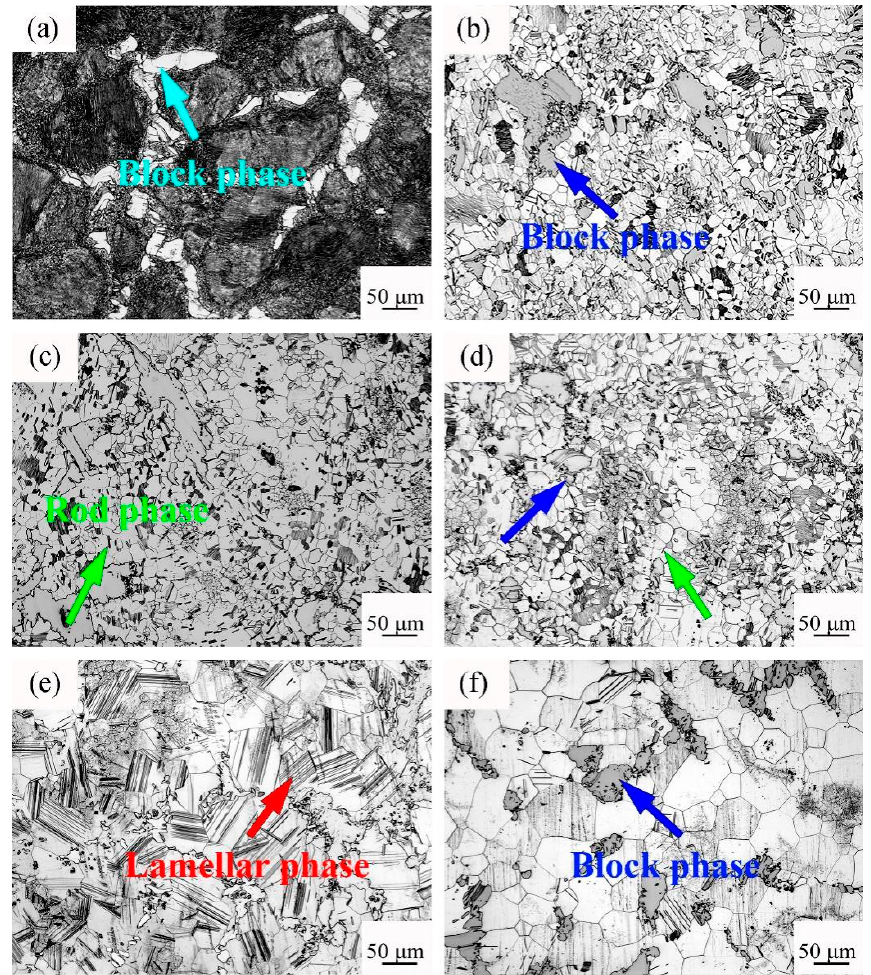
Figure 2. OM image of Mg–9Gd–2Y–2Zn–0.5Zr alloy after different heat treatments. ( a ) Original state, ( b ) 460 °C × 13 h, ( c ) 470 °C × 13 h, ( d ) 480 °C × 13 h, ( e ) 490 °C × 13 h, and ( f ) 500 °C × 13h.